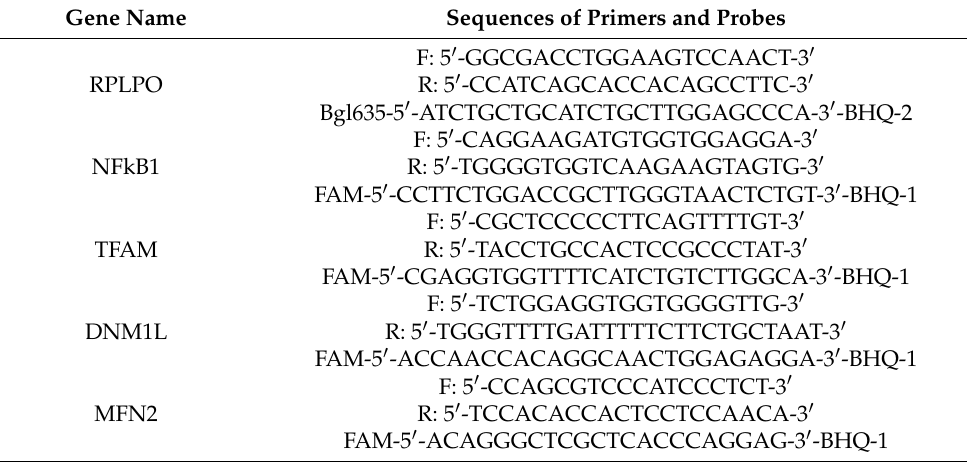
Table 1. Sequences of primers and probes for